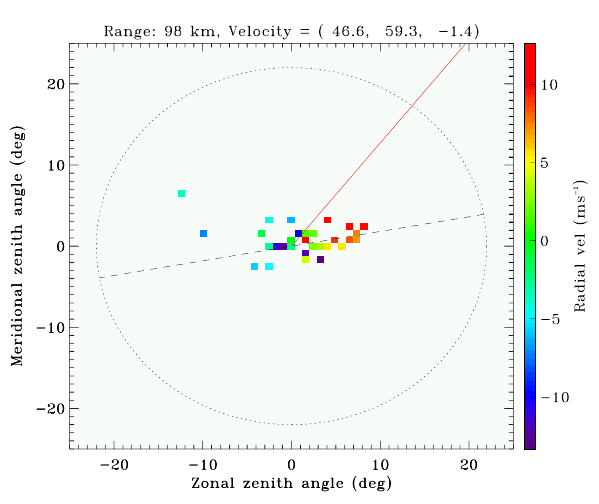
Fig. 2. Example of wind (red line) and scatterer azimuth (dashed line)